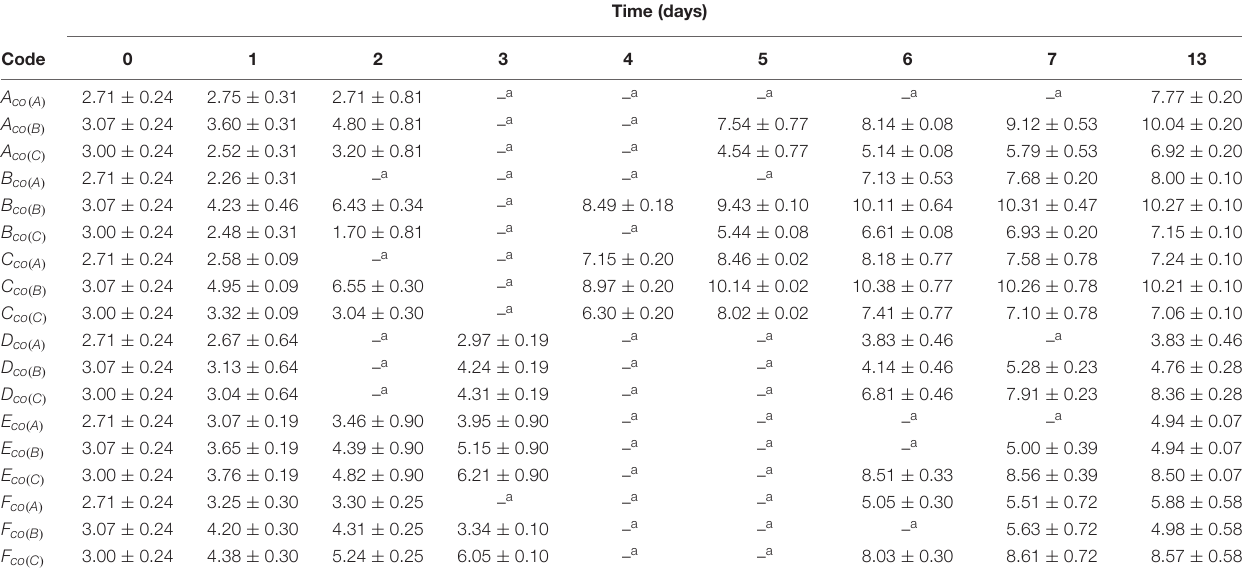
TABLE 3 | Estimate bacterial counts for co-culture